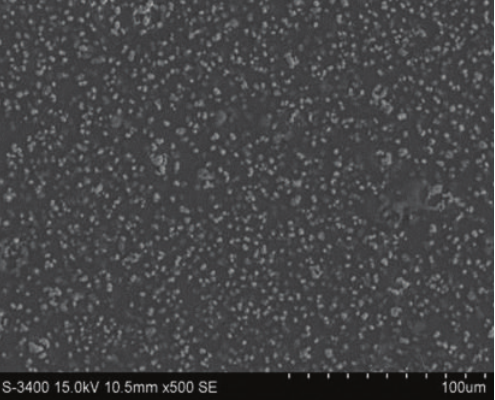
Figure 3: The SEM image of PANI/PVA composite